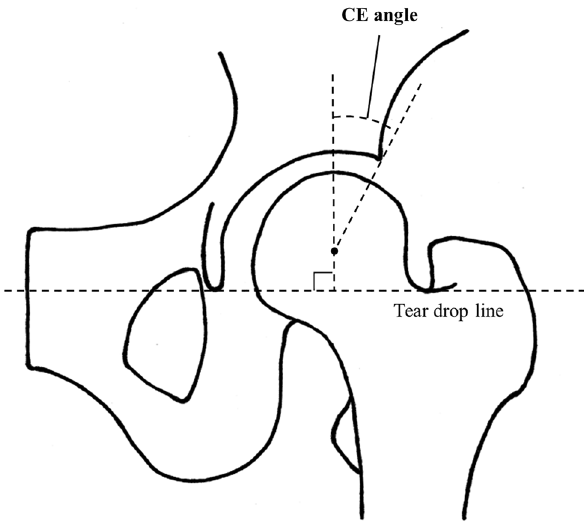
Figure 1. Measurement of the center-edge (CE) angle. The angle formed by a vertical line drawn from the center of the femoral head perpendicular to the teardrop line and a line drawn from the center of the femoral head to the lateral edge of the acetabulum is